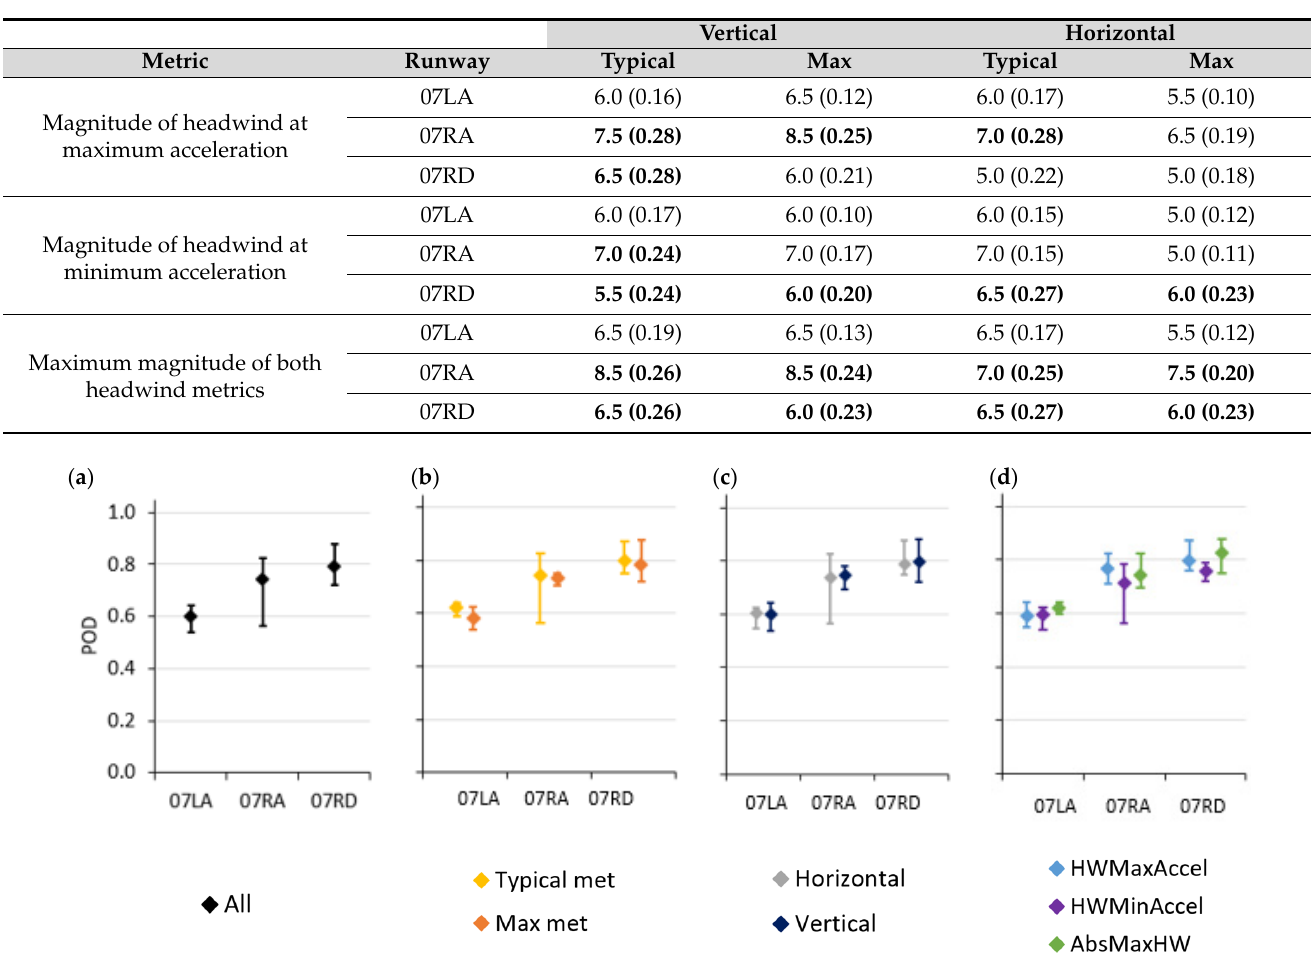
Figure 13. Modelled minimum, maximum, and average probability-of-detection ranges for each runway, including variations with meteorological inputs and metrics: ( a ) overall, ( b ) binned according to typical and maximum wind-speed inputs, ( c ) binned according to horizontal- or vertical-acceleration metric type, and ( d ) binned according to headwind-metric